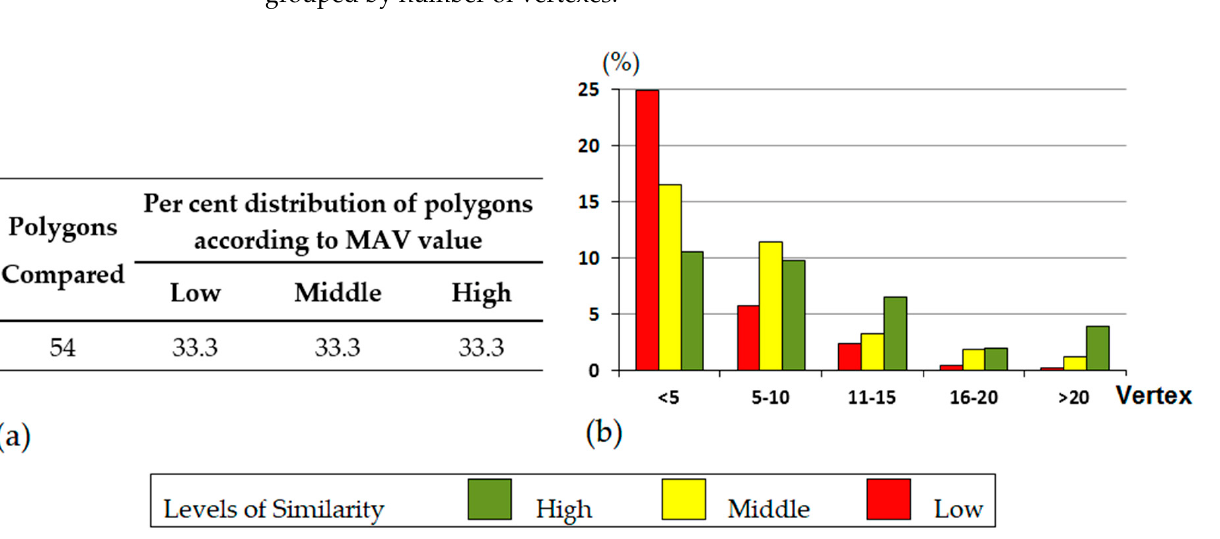
Figure 6. Graphical user interface. ( a ) Interface belonging to the MAV experiment; ( b ) interface belonging to the matching experiment.